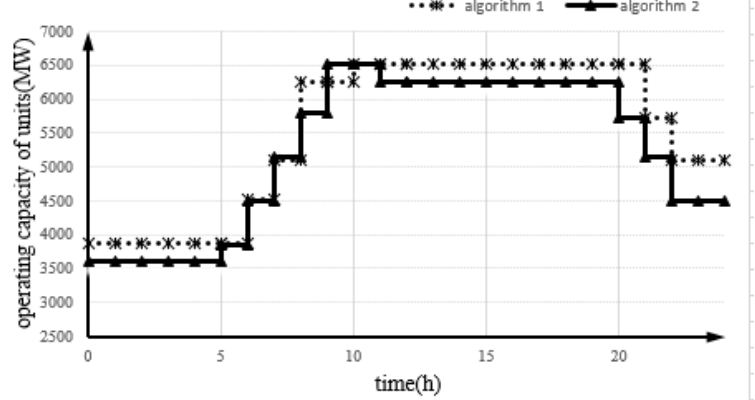
Figure 6. Operating capacity of units obtained using Algorithms 1 and 2.